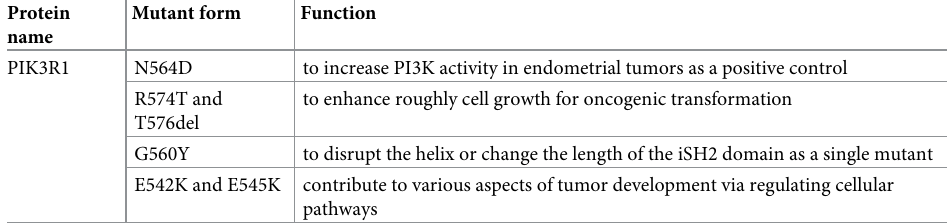
Table 4. Role of some functionally essential mutated amino acids in the iSH2 domain.